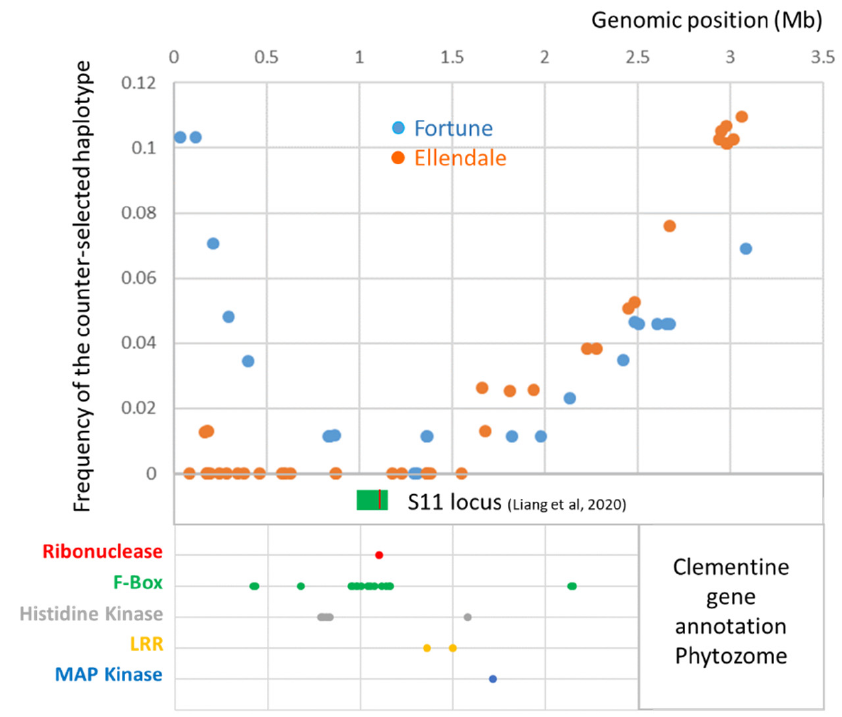
Figure 5. Gene annotation in the fully skewed genomic region of chromosome 7 for the male parents. The green box indicates the position of the S11 locus and the red line in this box the position of the ribonuclease gene involved in SI, identified by Liang et al. [46].